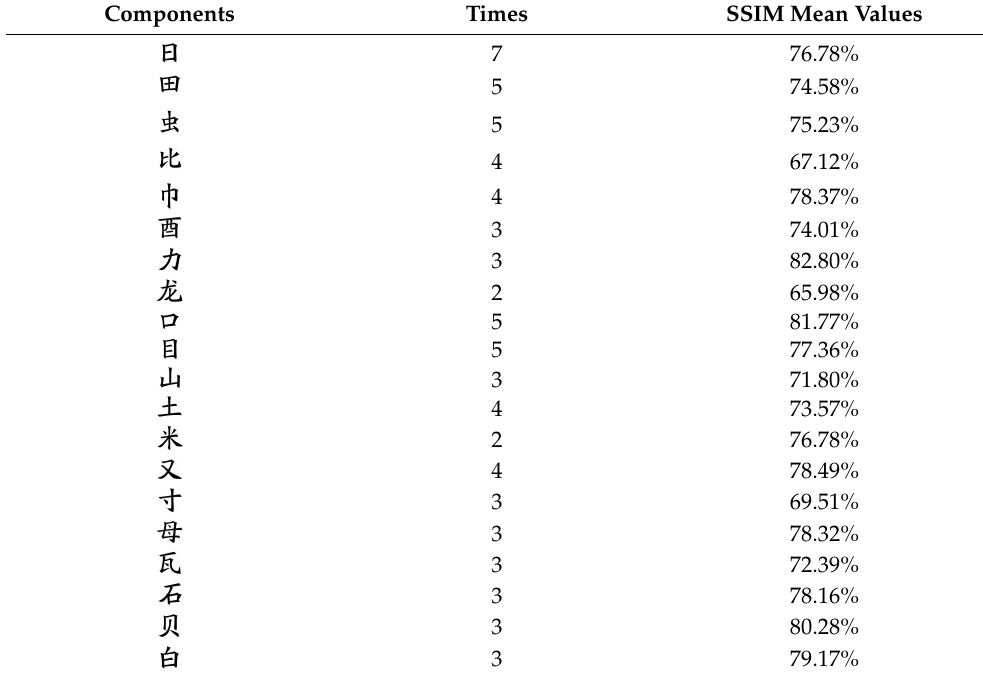
Table 5. Number of component deformations and the corresponding SSIM mean values.